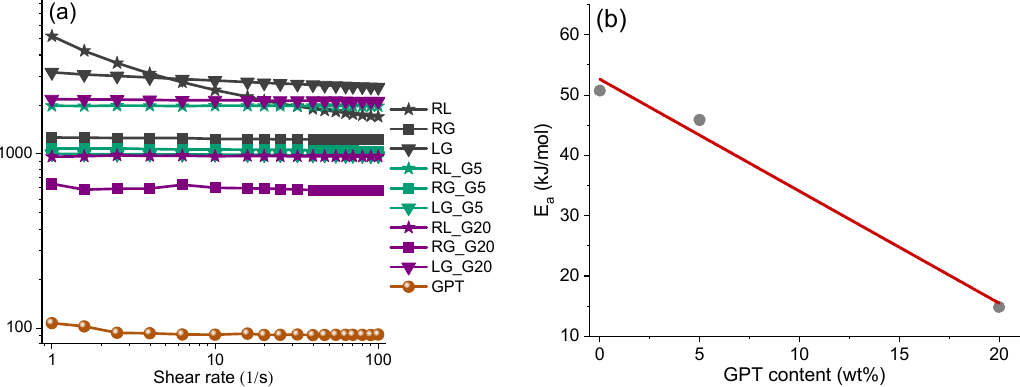
Figure 2. ( a ) Viscosity of acrylated vegetable oil resins with GPT; ( b ) activation energy ( E a ) drop with an increasing GPT content in RG coating.